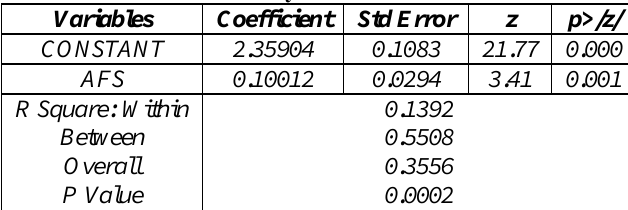
Table 4. Summary of Fixed Effect